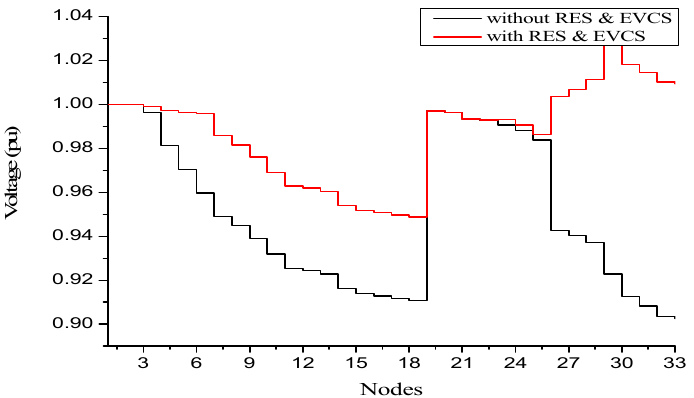
Figure 10. Voltage with and without RES and EVCS.